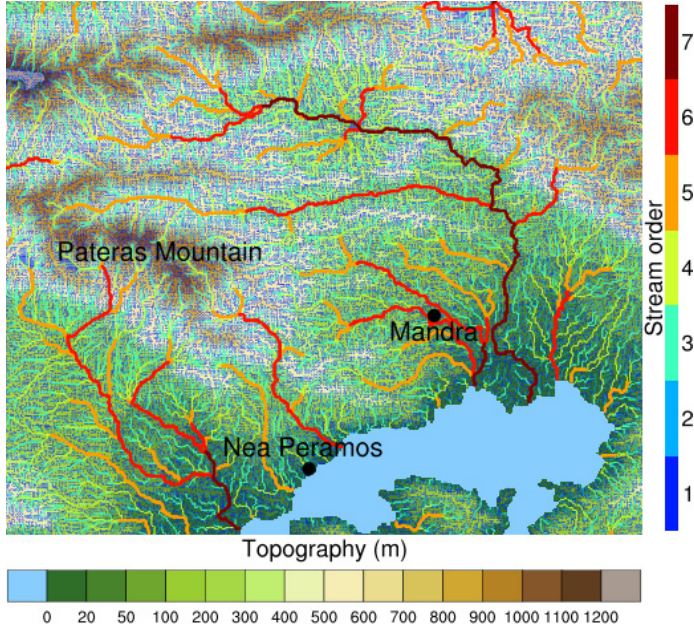
Figure 3. Topography of dimensions 50 m × 50 m and stream-order distribution used by the hydrological WRF-Hydro model, as well as three areas represented by black dots—Pateras mountain, Mandra town, and the Nea Peramos town (reconstruction of the original presented by Varlas et al. [36]). Table 1. Manning roughness coefficient (Manning), bottom width (CBW) in meter, initial water depth (IWD) in meter, and slide slope (CSS) of channels for each stream order (source [36]). Stream Order